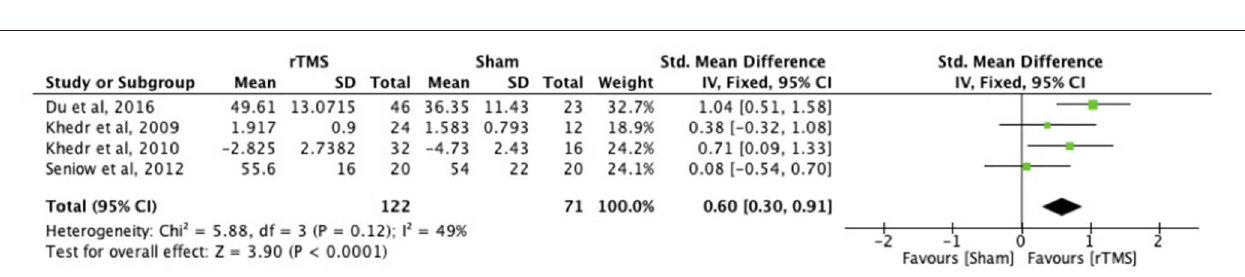
FIGURE 5 | Effects of rTMS applied within 1 month with outcome assessment at 3 months post-stroke. Estimates of effect size are shown with 95% CIs. The standardized mean difference (SMD) and 95% confidence intervals (CIs); ICF Function measures: Fugl-Meyer Arm and Grip